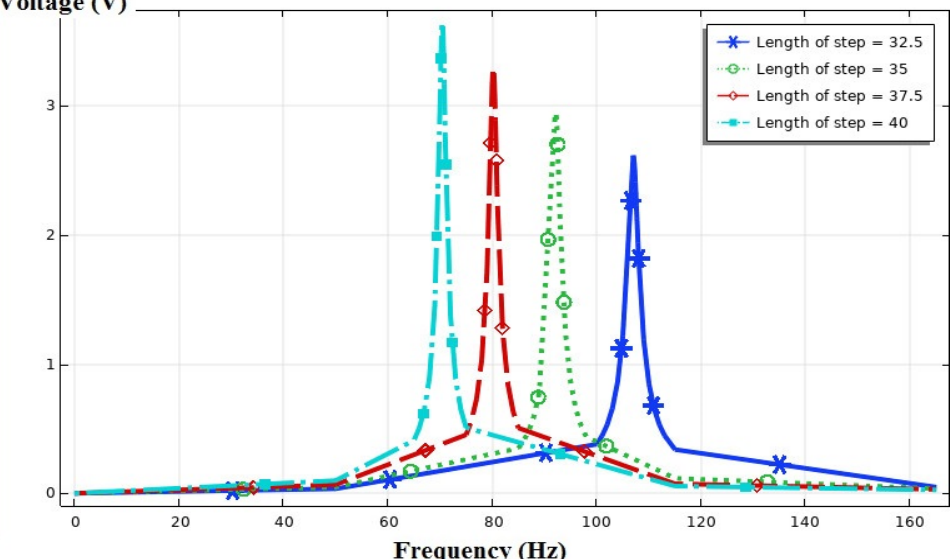
Figure 12. The output voltage vs. the frequency for different two-step beam lengths, L 1 = L 2 = [ 32.5, 35, 37.5, 40 ] mm.